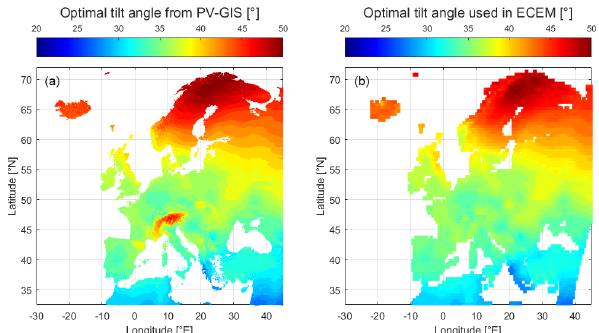
Figure 3. Comparison of the experimental histograms of two mod- ule orientation angles (blue bars) with the fitted normal distribution function (red lines) for the module azimuth angle (a) and the mod- ule tilt angle (b) . N(180, 19.3) (a) means that the average orientation is 180 ◦ and the standard deviation is 19.3 ◦ . N(20.6, 10.8) (b) means an average tilt angle of 20.6 ◦ and a standard deviation of 10.8 ◦ .